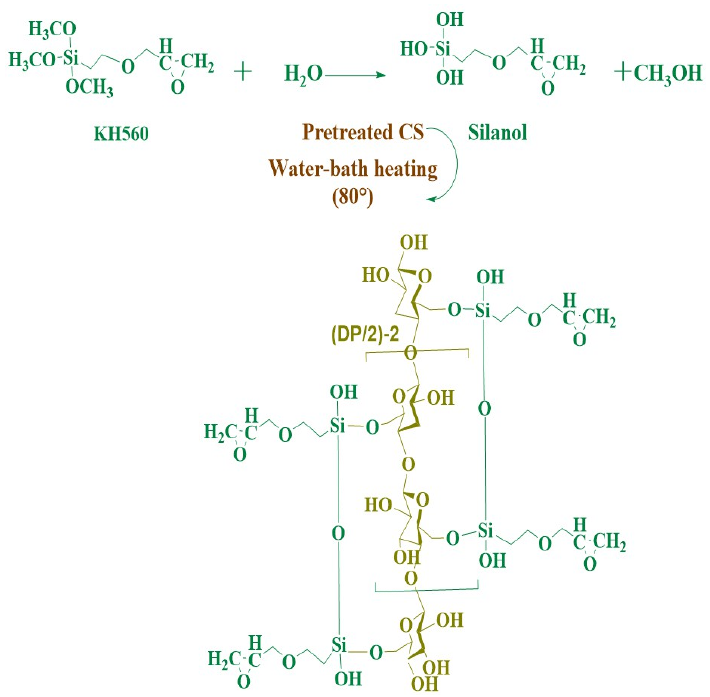
Scheme 1. The mechanism of CS modified by